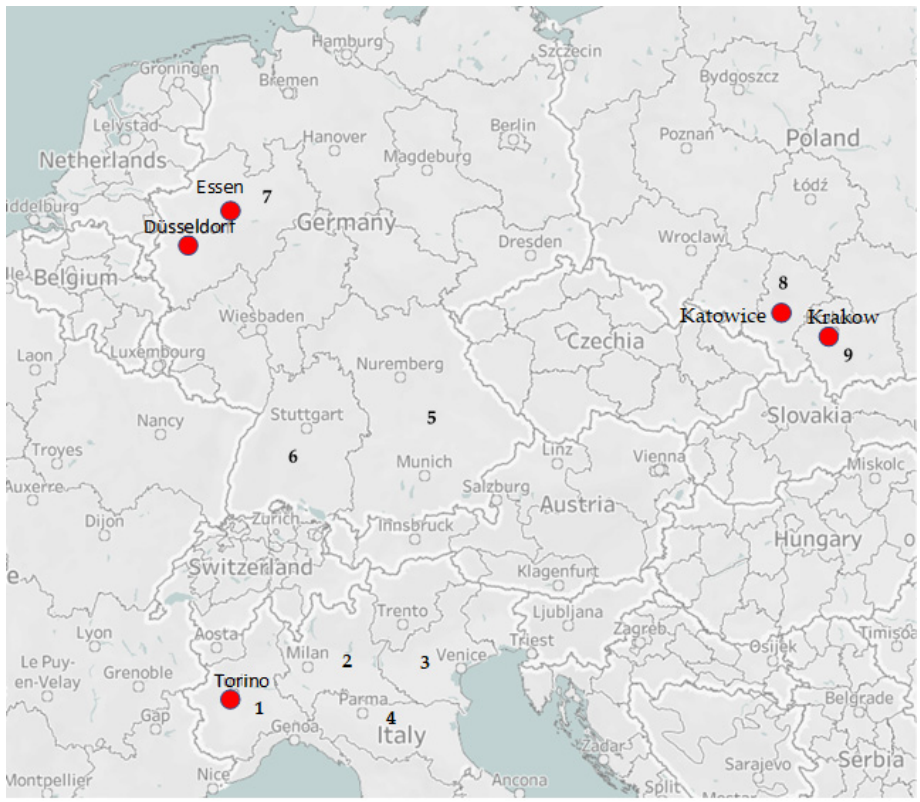
Figure 1. Studied European regions in Italy (1 Piedmont, 2 Lombardy, 3 Veneto, 4 Emilia Romagna), Germany (5 Bavaria, 6 Baden-Württemberg, 7 North Rhine-Westphalia), and Poland (8 Silesian, 9 Lesser Poland).